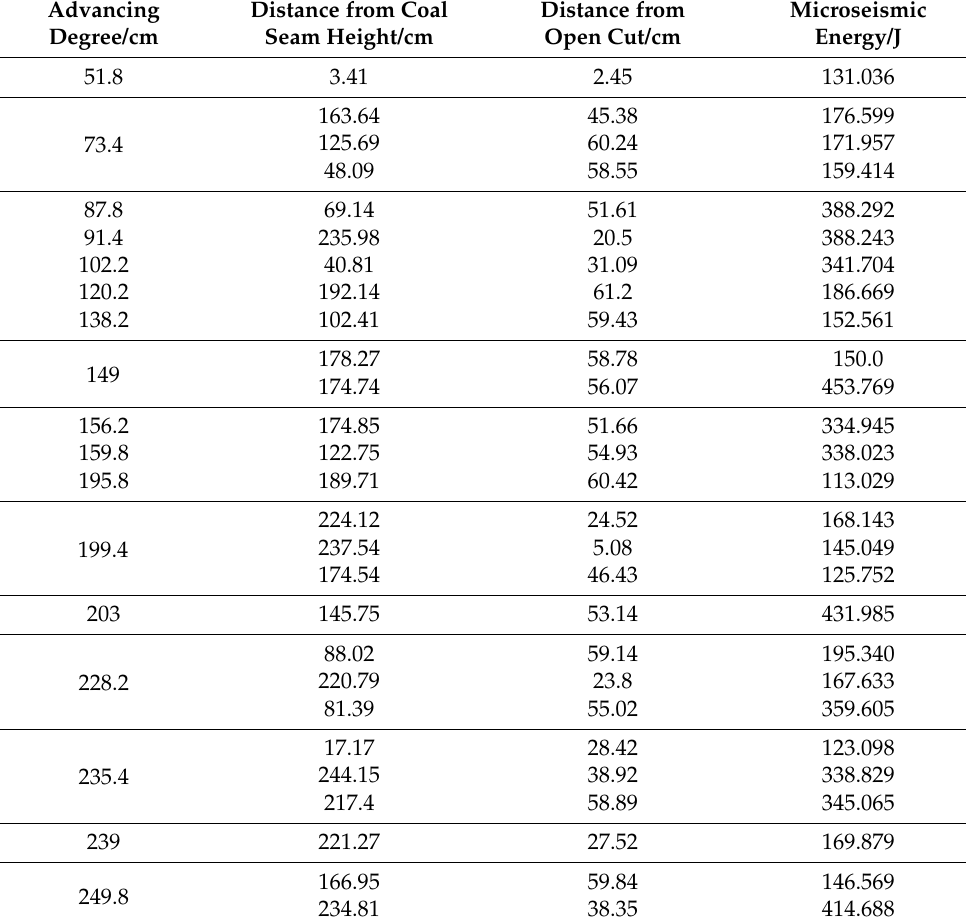
Table 2. Statistical table of crack position in physical